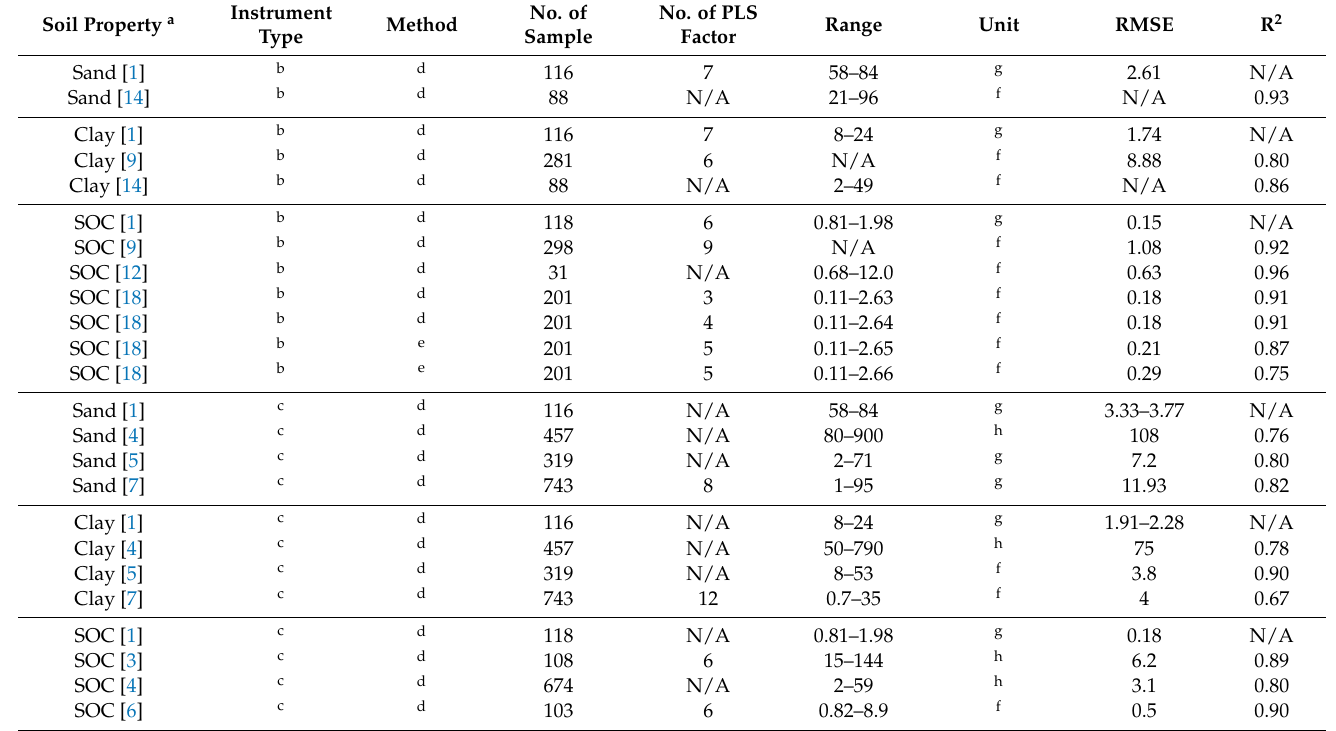
Table 1. Selected examples from literature comparing quantitative predictions of sand, clay, and SOC using spectral response from vis-NIR and mid-IR